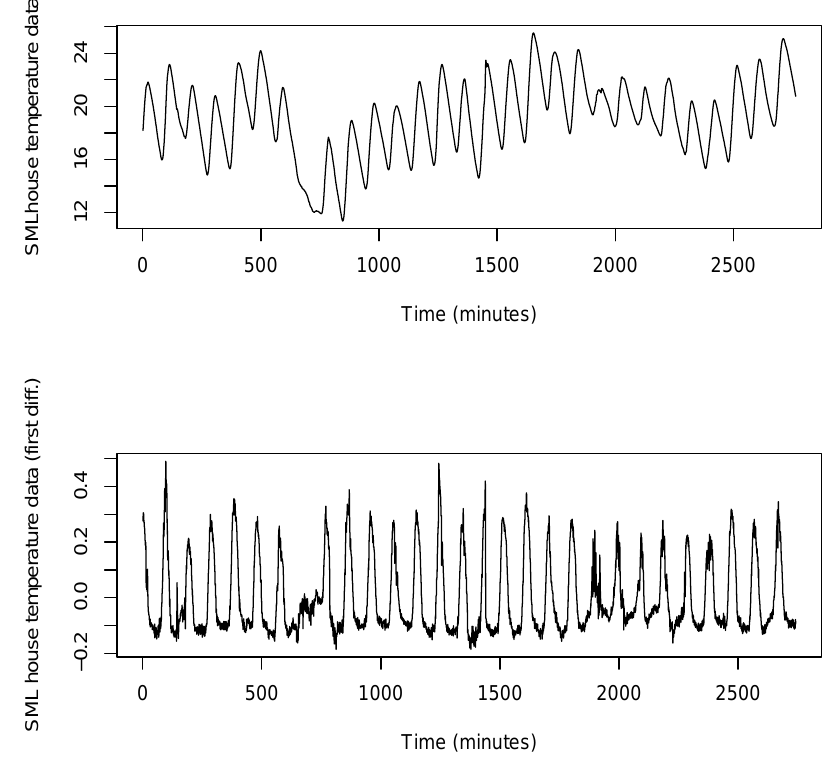
Figure 12. SMLhouse time series